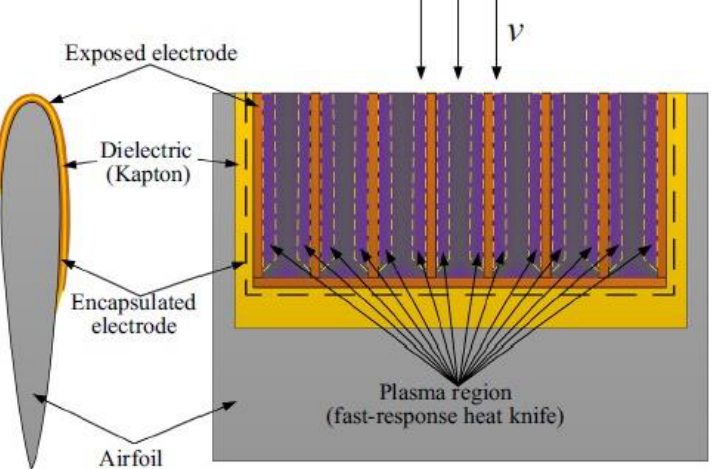
Figure 21. Side and top view of the “stream-wise plasma heat knife” (adapted from Wei et al. [119] with the permission of Elsevier).